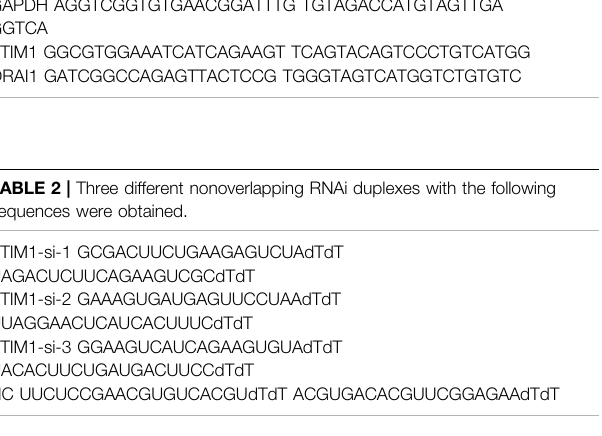
Frontiers in Pharmacology |